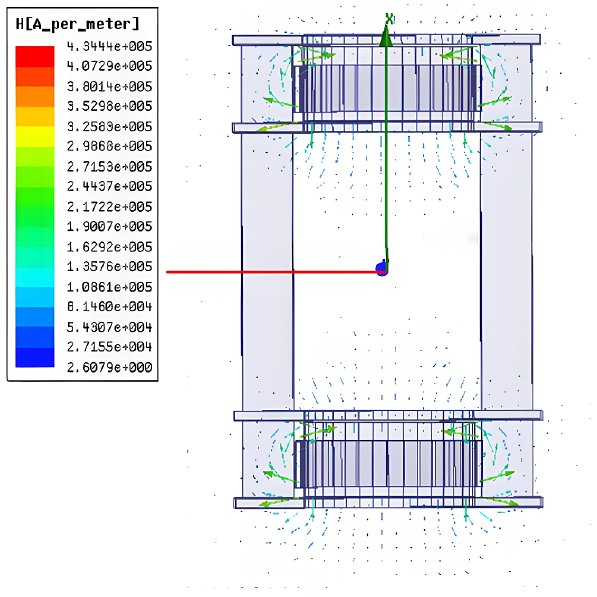
Figure 13. Helmholtz coil X-Y plane magnetic induction line distribution.